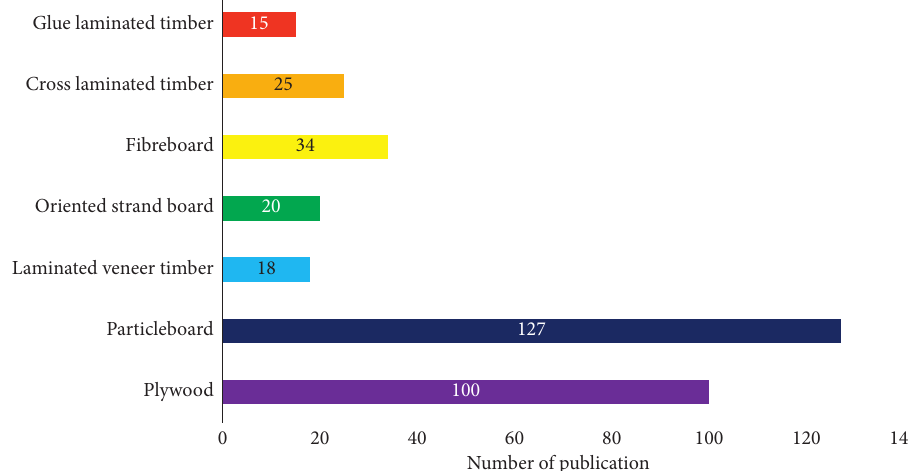
Figure 4: Number of publications on EWPs fabricated from Eucalyptus